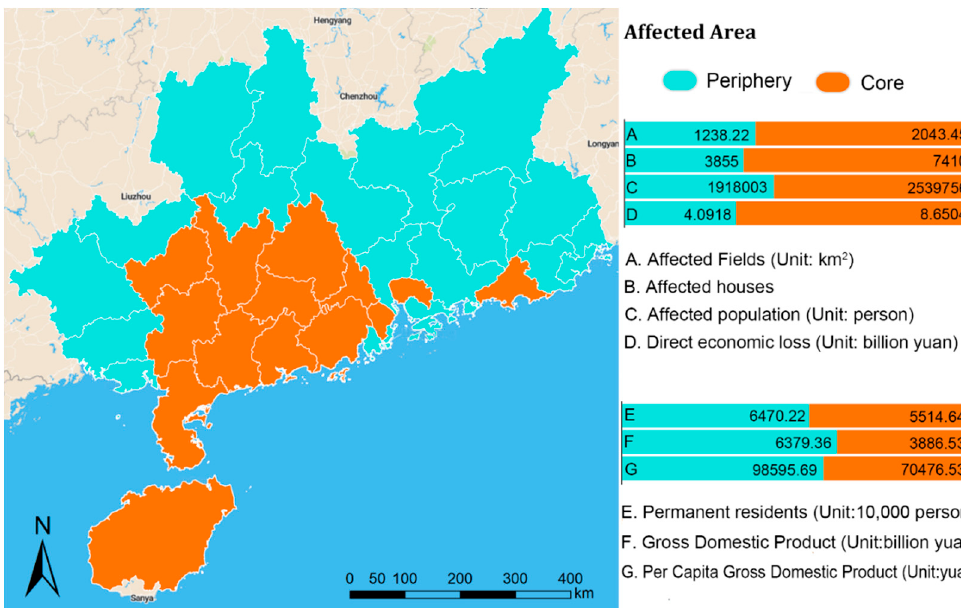
Figure 8. Core–periphery classification matrix of disaster network. Note: There are 13 h in core block that also belong to the “peak time period”.